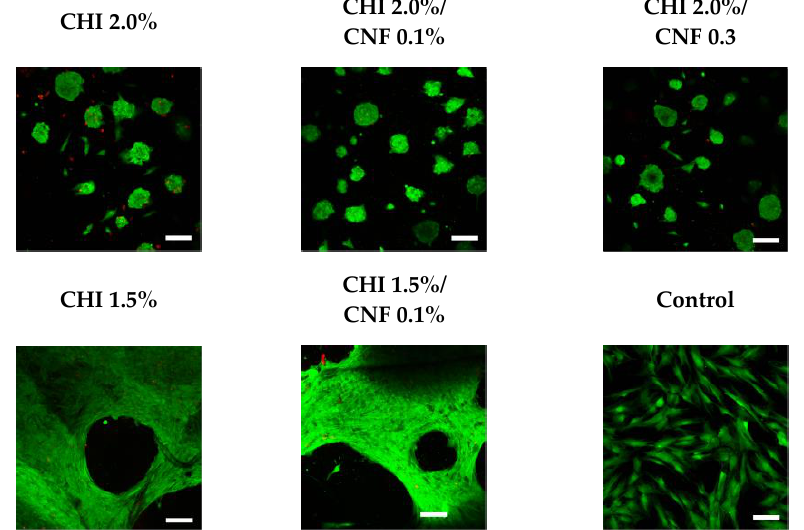
Figure 8. Live-dead assay performed after 24 h of cell culture of human dermal fibroblast (HFIB-D) cells on cellulose nanofiber-filled chitosan (CNF/CHI) hydrogels of different CHI concentrations and CNF contents. Scale bar: 100 μ m.